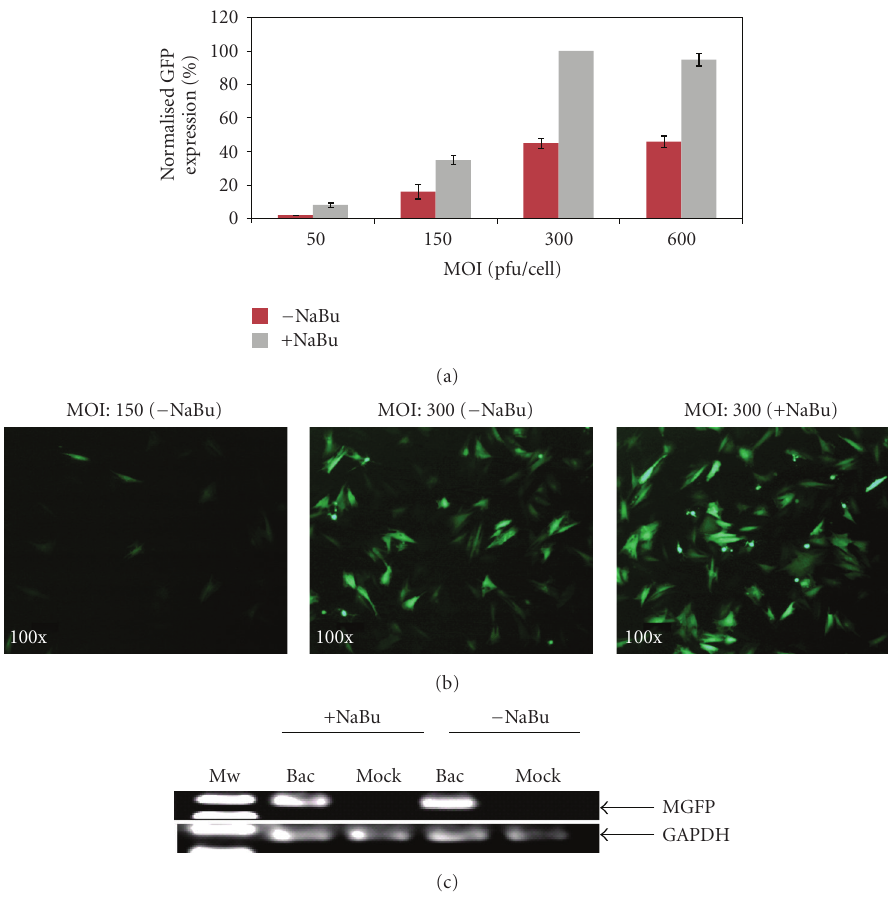
Figure 3: E ff ect of NaBu and viral dose in H9c2 cells’ transgene expression. Cells were transduced with Bac-MGFP for 6 h in PBS at 27 ◦ C with and without 10 mM NaBu treatment at di ff erent viral doses. Quantification (fluorescein expression) of fluorescent in H9c2 cells (a) were made with relation to viral dosage 24hpt. The average fluorescein-expressed (excitation 485 nm, emission 535 nm) values were normalized to that of the cells having 6h of viral incubation in presence of PBS (taken as 100%) and are represented as normalized mean expression in percentage value. The data represent mean of three di ff erent readings. (b) Fluorescence images of transduced cells in absence and presence of NaBu are shown 24 hpt. (c) Detection of MGFP plasmid delivery in H9c2 cells 24hpt in presence or absence of NaBu by standard PCR analysis. Cells were given equal viral dose with same viral incubation time. Nontransduced cells were taken as the control (mock) for the transduction procedure. The DNA was extracted from the transduced cells 24h after transduction, and PCR analysis was done using primers that amplify the delivered MGFP gene. Amplification of housekeeping GAPDH gene serves as an internal control for the e ffi ciency of polymerase reaction. Molecular weight (Mw) markers are low range DNA ladder. The similar band intensities in the agarose gel indicates that there was equal viral transduction in both +NaBu and − NaBu groups, although the corresponding protein expression was higher in +NaBu (as shown in (a) and (b)). This proves that NaBu does not interfere in viral transduction procedure but significantly improves the transgene